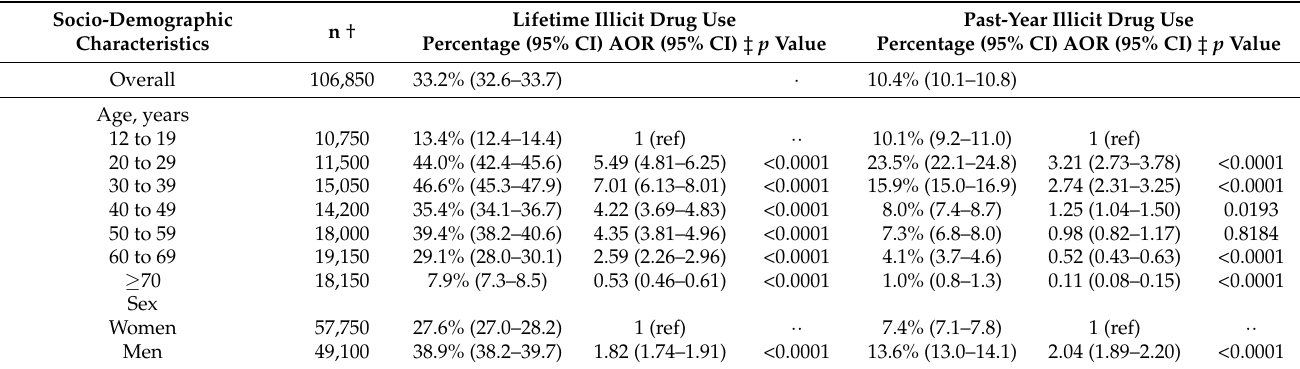
Table 2. Prevalence of lifetime, and past-year illicit drug use in